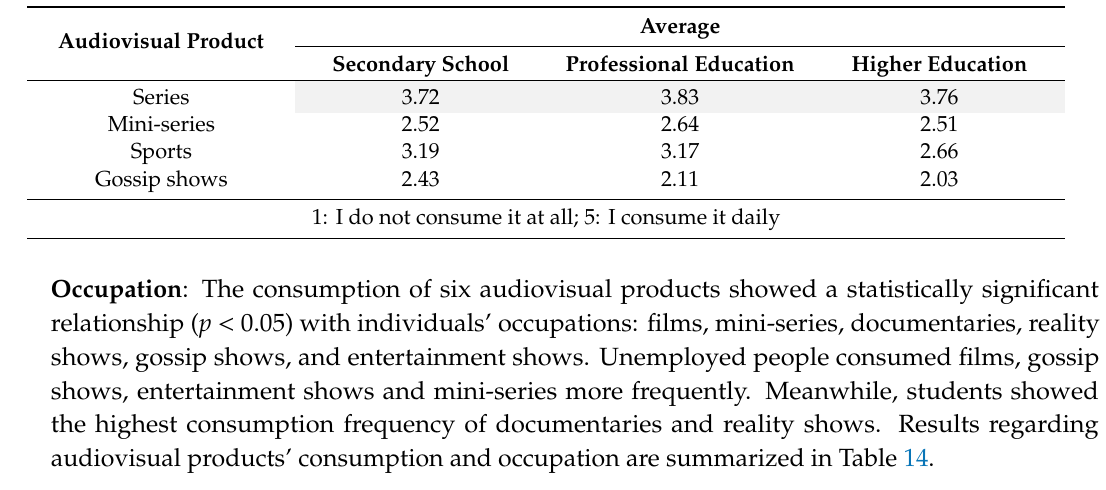
Table 13. Audiovisual products consumption according to education (averages).